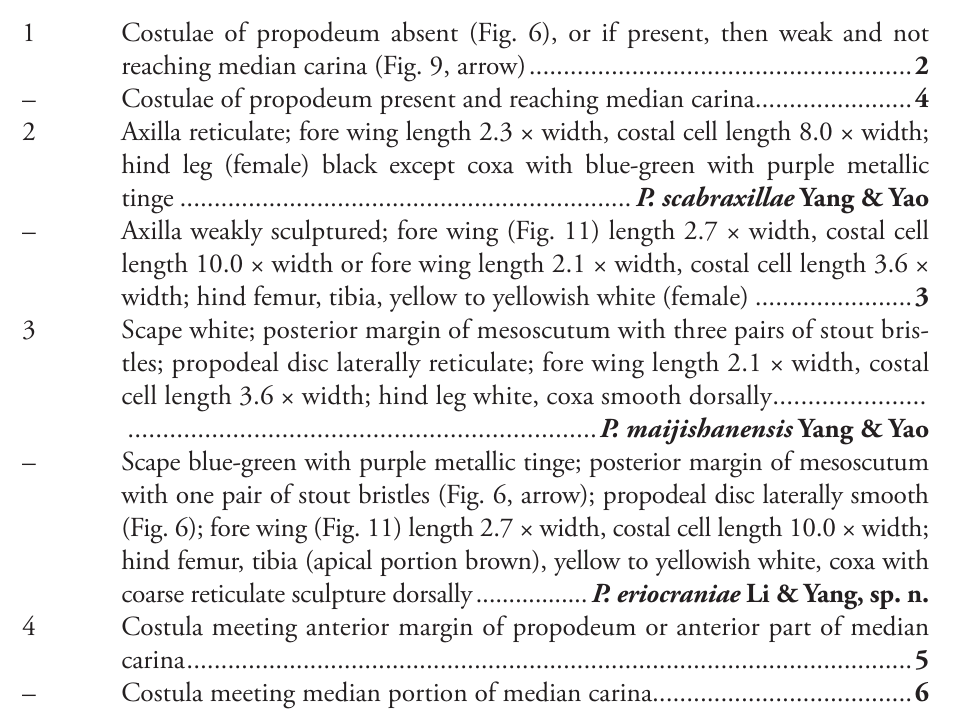
Scape white; posterior margin of mesoscutum with three pairs of stout bris- tles; propodeal disc laterally reticulate; fore wing length 2.1 × width, costal cell length 3.6 × width; hind leg white, coxa smooth dorsally ...................... Scape blue-green with purple metallic tinge; posterior margin of mesoscutum with one pair of stout bristles (Fig. 6, arrow); propodeal disc laterally smooth (Fig. 6); fore wing (Fig. 11) length 2.7 × width, costal cell length 10.0 × width; hind femur, tibia (apical portion brown), yellow to yellowish white, coxa